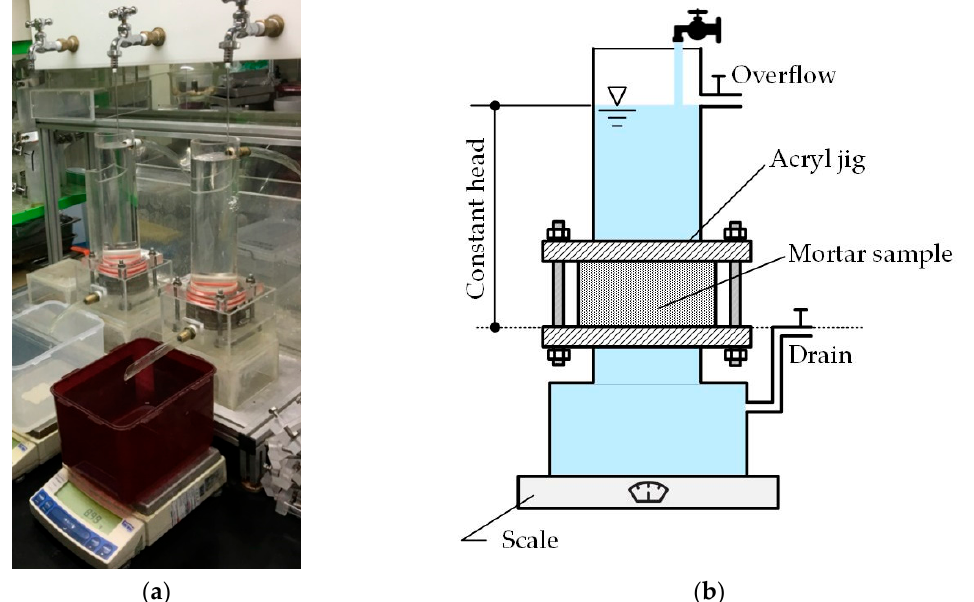
Figure 2. Water flow test: ( a ) photograph of actual test on mortar; ( b ) schematic illustration.